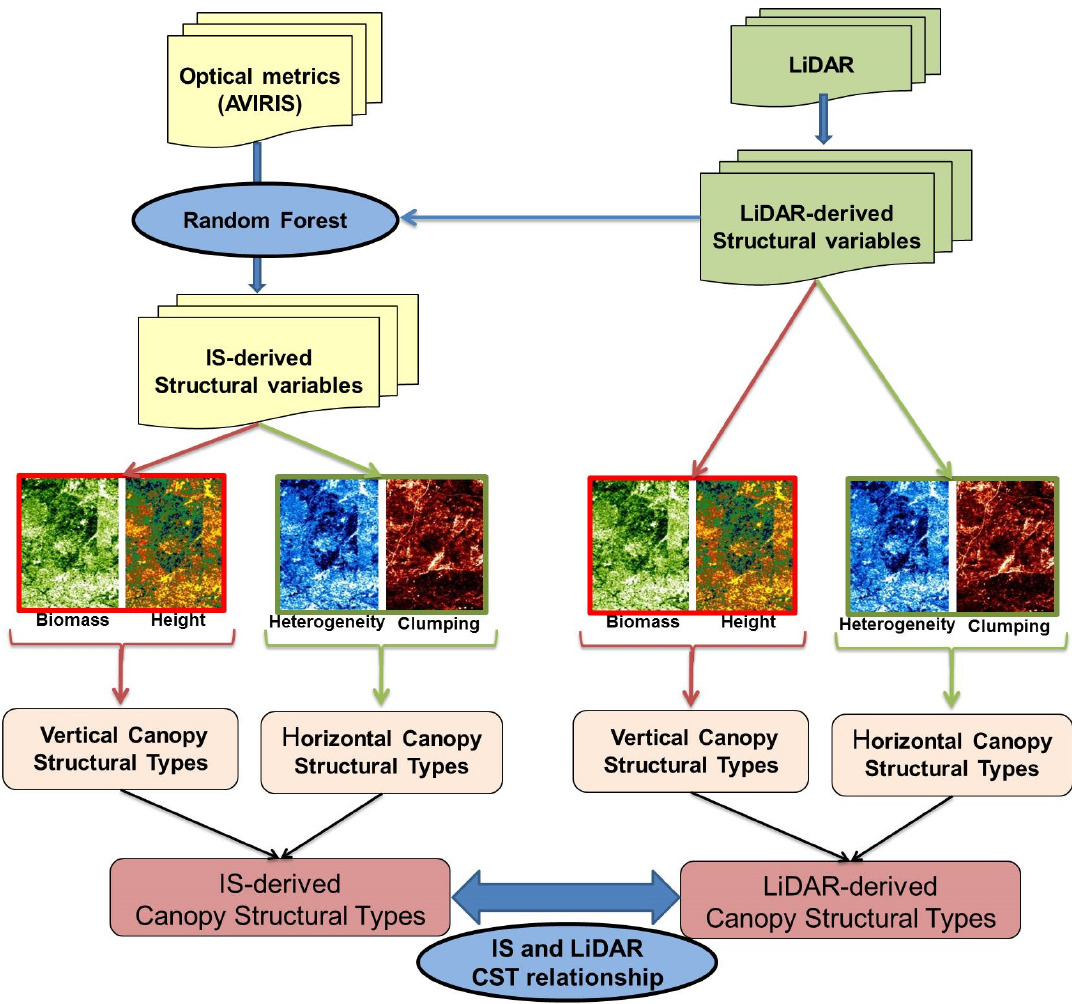
Figure 2. Methodology flowchart.